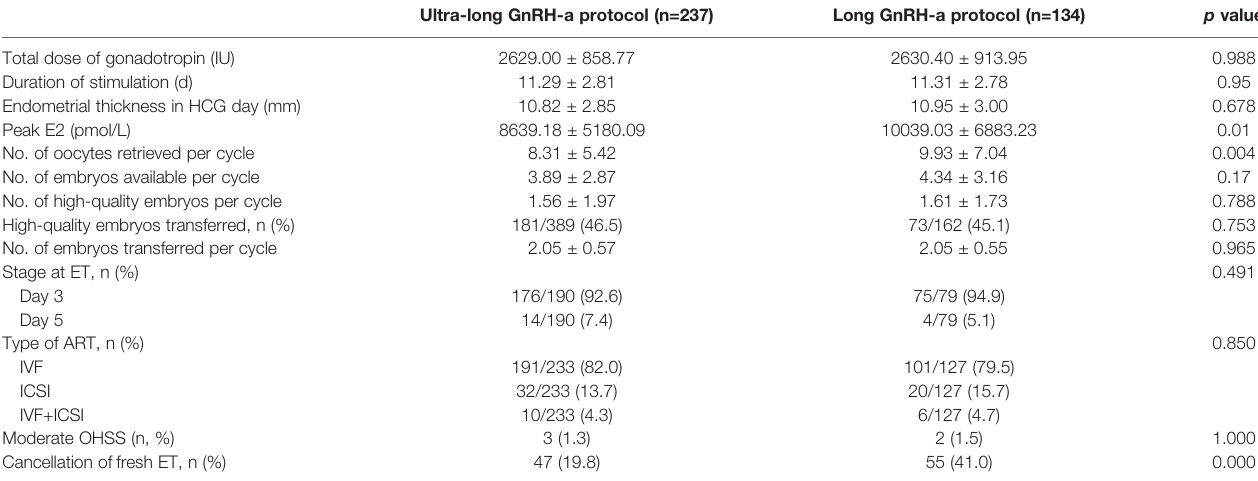
TABLE 2 | Cycle characteristics of the